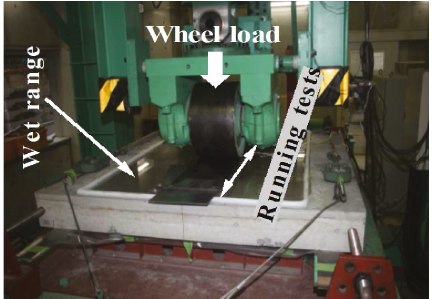
Figure 4: Appearance of running load fatigue testing machine and the speci fi cations for the water fi